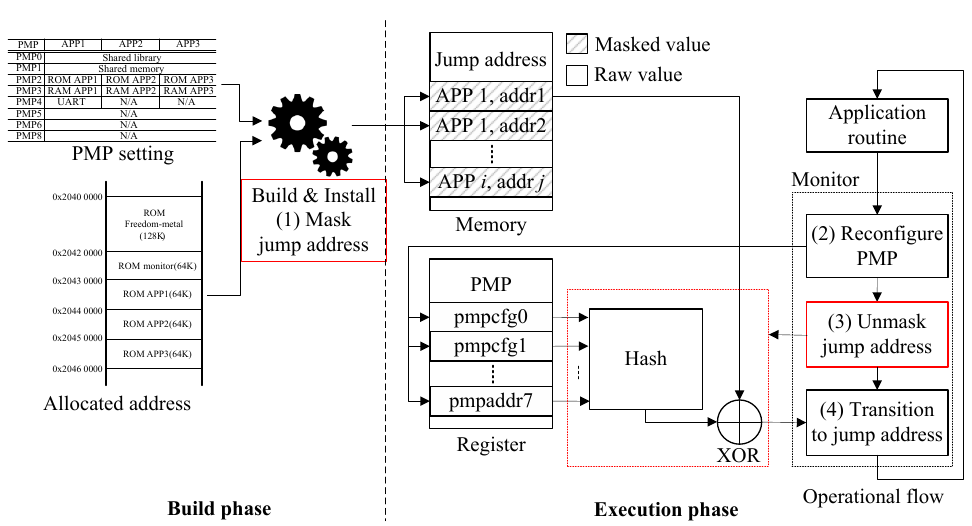
Figure 14: Operational flow of jump-address masking. Processes marked in red are added to the original build and execution process for